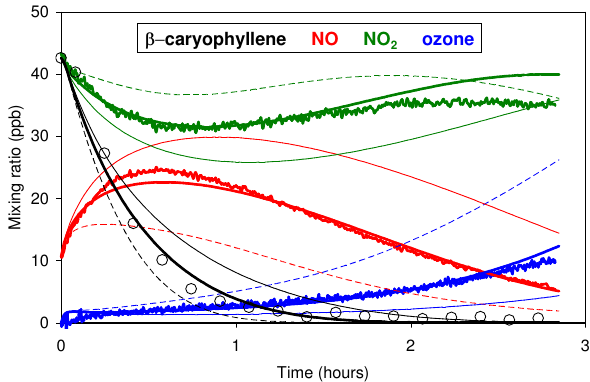
Fig. 11. Time profiles of β -caryophyllene, NO, NO 2 and ozone for ACES photo-oxidation experiment 03-07-08. The observed β - Figure 11. Time profiles of E(cid:16) caryophyllene, NO, NO 2 and ozone for ACES photo-oxidation 3 caryophyllene data are shown as open circles, with the observed experiment 03-07-08. The observed E(cid:16) caryophyllene data are shown as open circles, with the 4 NO, NO 2 and ozone data as continuous lines. The smooth lines observed NO, NO 2 and ozone data as continuous lines. The smooth lines show the results of 5 show the results of simulations using the MCM v3.2 scheme, simulations using the MCM v3.2 scheme, with different yields of OH (and co-radicals) from 6 with different yields of OH (and co-radicals) from β -caryophyllene ozonolysis. Broken lines: OH yield=10% (i.e., the base MCM E(cid:16) caryophyllene ozonolysis. Broken lines: OH yield = 10% (i.e., the base MCM v3.2 run); 7 v3.2 run); Heavy continuous lines: OH yield=6%; Feint contin- Heavy continuous lines: OH yield = 6%; Feint continuous lines: OH yield = 3%. 8 uous lines: OH